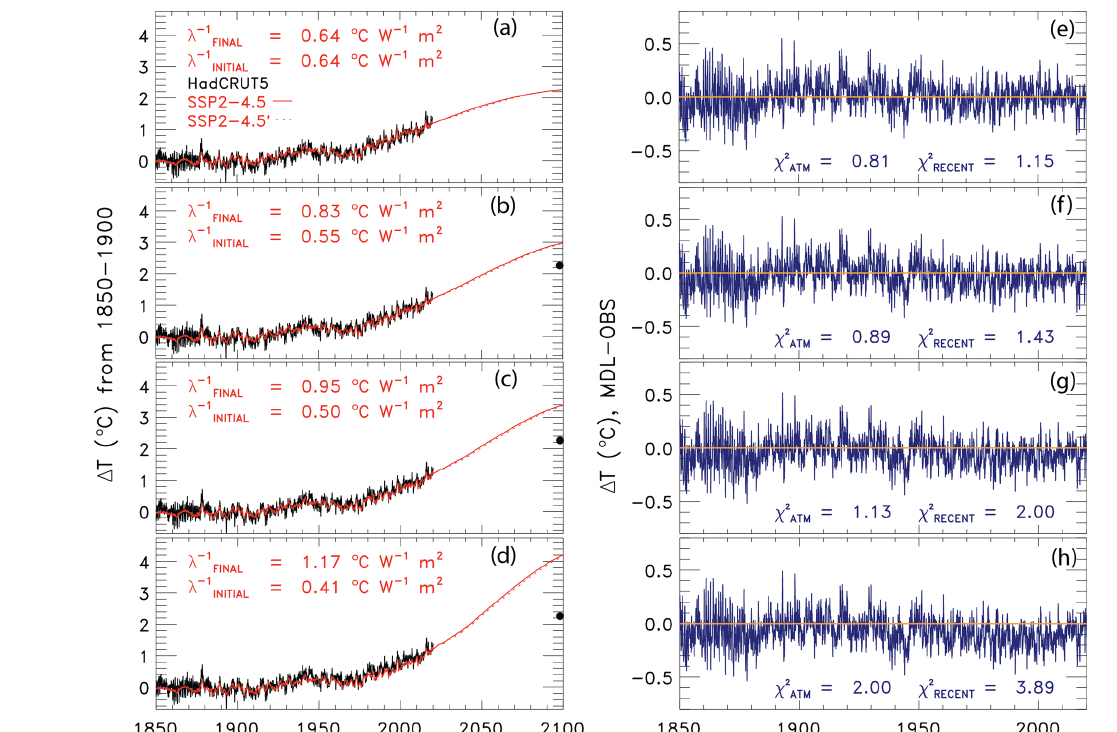
Figure 14. Change in GMST from 1850–2019 for observations from HadCRUT5 (black) and 1850–2100 modeled (red) using SSP2-4.5 and a value of AER RF 2011 = − 0 . 9Wm − 2 as well as the residual between the model and observations incorporating a 32.5-year delay between λ − 1 and a change in RF. The solid line denotes a simulation for the original SSP2-4.5 scenario, and the dashed line indicates the SSP2-4.5’ simulation (see text). (a) Rise in GMST assuming a constant value of λ − 1 . (b) Rise in GMST allowing λ − 1 to increase by 50%. (c) Rise in GMST allowing λ − 1 to vary, while the value of χ 2 is kept below 2. (d) Rise in GMST allowing λ − 1 to vary, while the value of χ 2 RECENT ATM is kept below 2. (e) Residual between the modeled and observed rise in GMST from 1850–2019 for constant λ − 1 . (f) Same as (e) but for increasing λ − 1 by 50%. (g) Same as (f) but for varying λ − 1 , while the value of χ 2 is kept below 2. (h) Same as (g) but for varying RECENT λ − 1 , while the value of χ 2 is kept below ATM